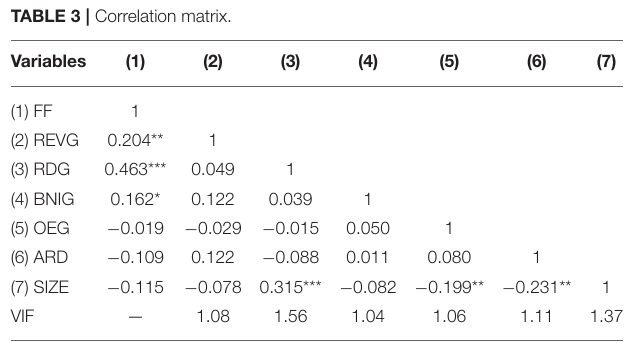
TABLE 3 | Correlation